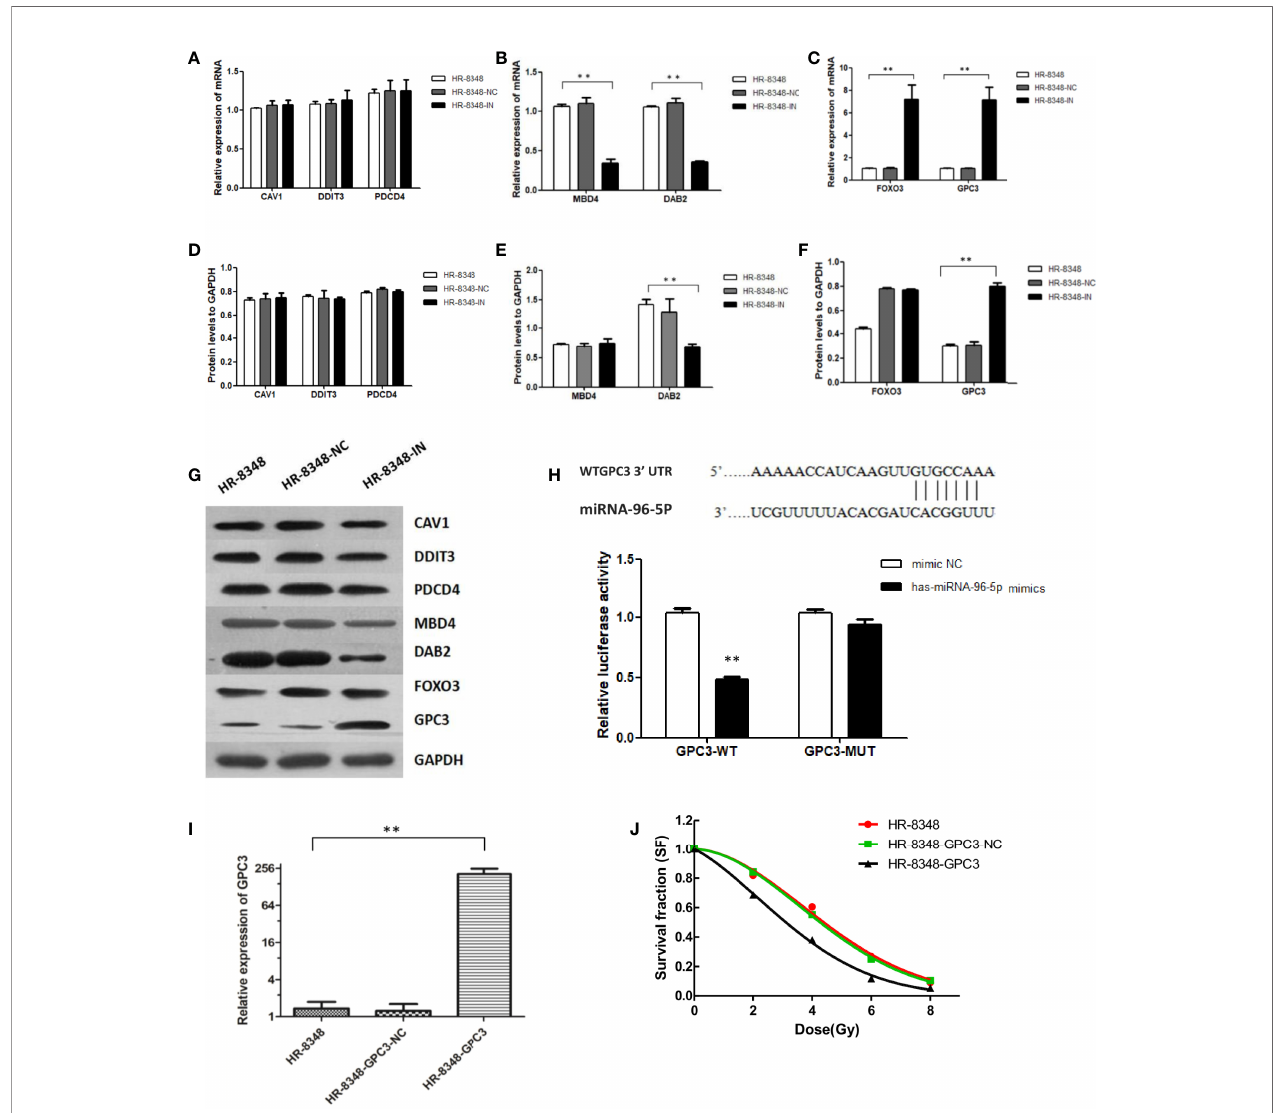
FIGURE 7 | Screening of target genes regulated by miRNA-96-5p and the effect of up-regulation of GPC3 expression on radiation reactivity of HR-8348 cells. (A – C) qRT-PCR assays were used to detect the expression levels of target genes in rectal cancer cells before and after miRNA-96-5p knockdown, and the mRNA expressions of FOXO3 and GPC3 were signi fi cantly up-regulated in HR-8348-IN cells; (D – G) Western blot assays were used to detect the expression of target genes in rectal cancer cells before and after miRNA-96-5p knockdown, and the protein expression of GPC3 was not signi fi cantly changed in HR-8348-NC cells, but was signi fi cantly up-regulated in HR-8348-IN cells; (H) Luciferase activity of the WT and mutant GPC3 3 ′ UTR co-transfected with miRNA-NC and miRNA-96-5p mimics, the GPC3-WT group was inhibited, but not in the GPC3-MUT group; (I) GPC3 was signi fi cantly up-regulated in HR-8348-GPC3 cells; (J) GPC3 over- expression in HR-8348 cells results in increased sensitivity to irradiation, and survival fraction fi tted to the linear quadratic equation. **P <